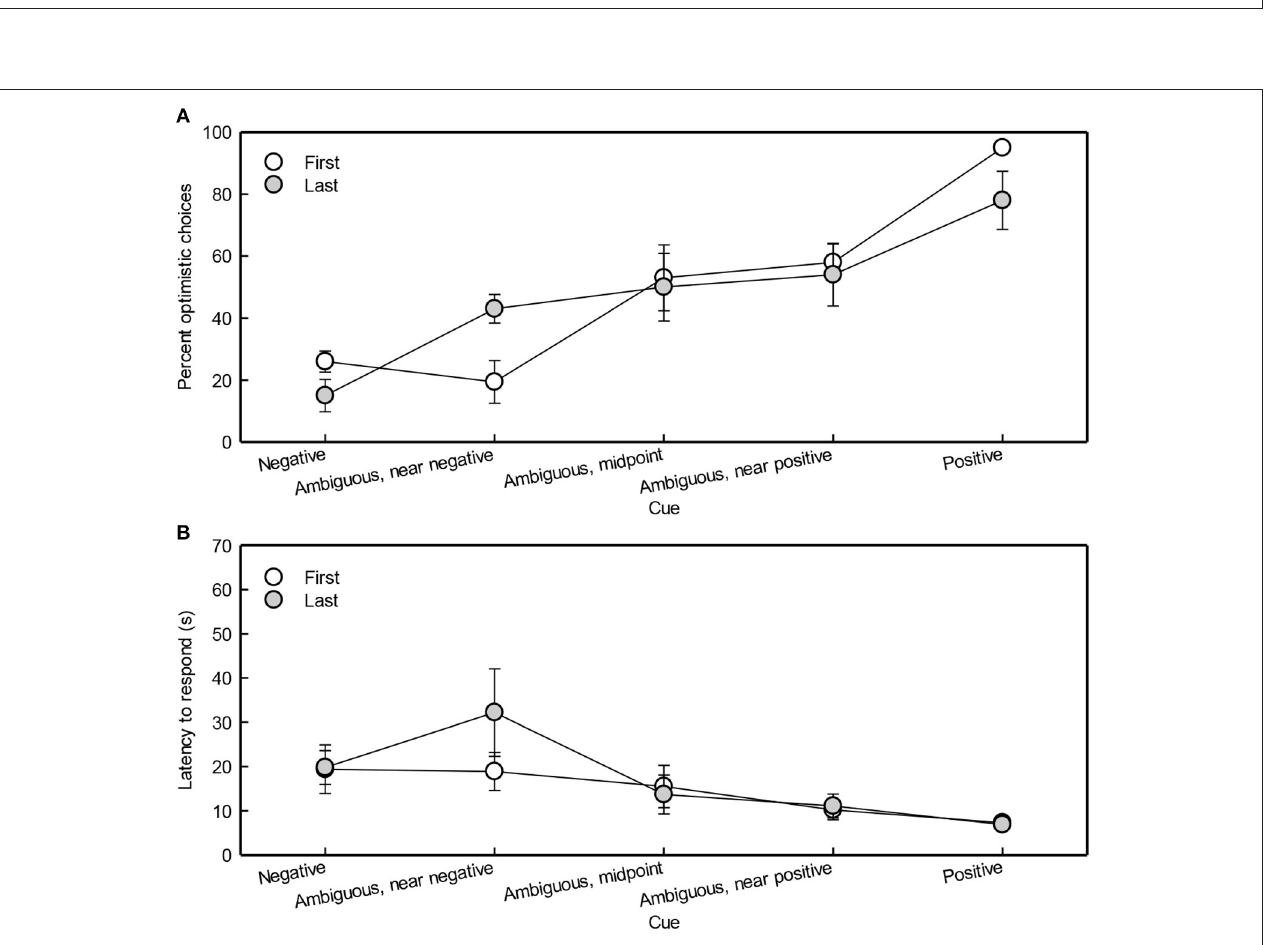
FIGURE 5 | Optimistic choices (A) and latencies of first and last-born pigs (B) during testing in the judgment bias task. The means ± SEMs are depicted.